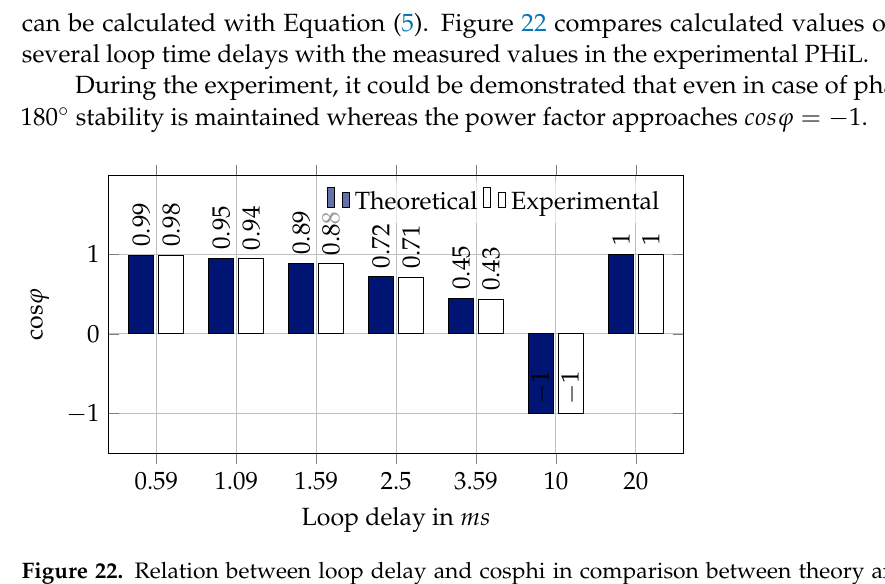
Figure 22. Relation between loop delay and cosphi in comparison between theory and practical PHiL